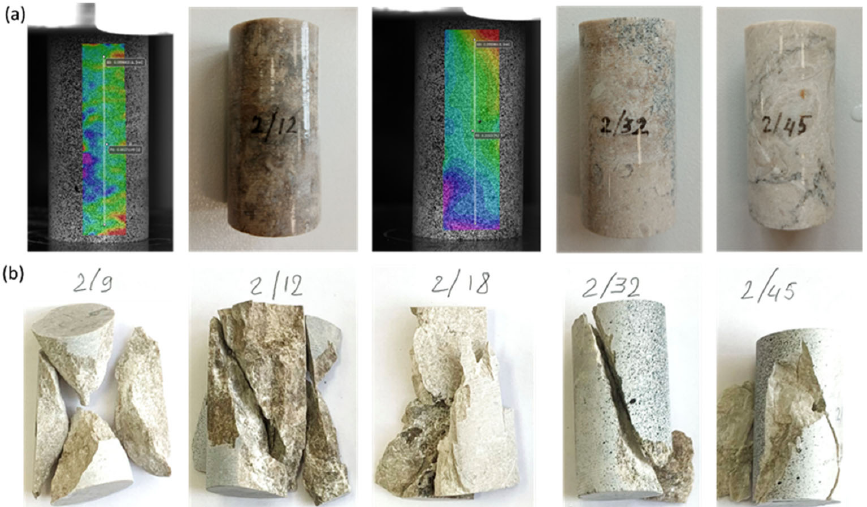
Figure 7. Photographs depicting water ‐ wet samples during testing for uniaxial compression: ( a ) samples before failure; ( b ) samples after testing demonstrating different failure modes, such as double shear (sample 2/9), shear along a single plane (samples 2/12, 2/32, 2/45) and Y ‐ shaped (sample 2/18).